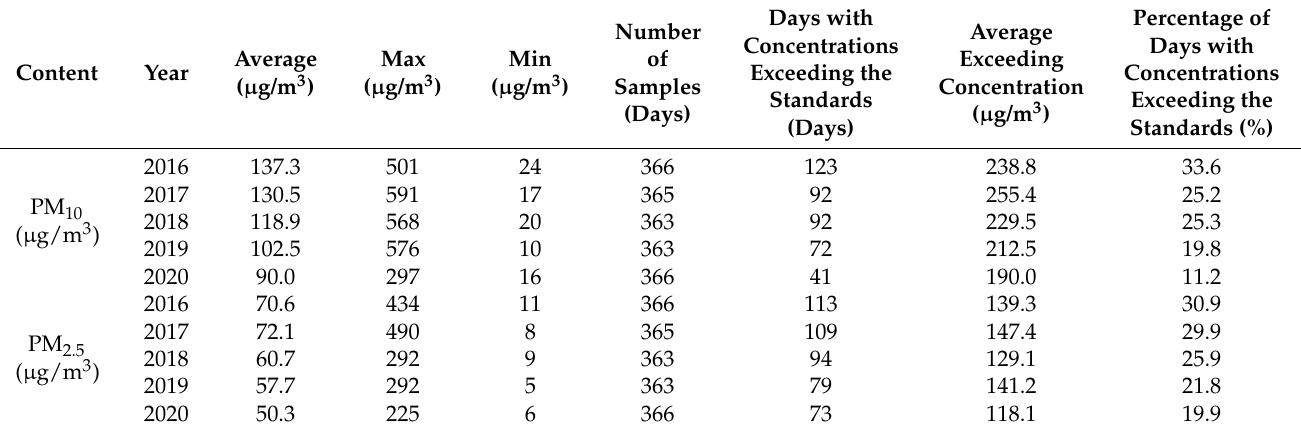
Table 1. Parameter statistics of PM 10 and PM 2.5 from 2016 to 2020.